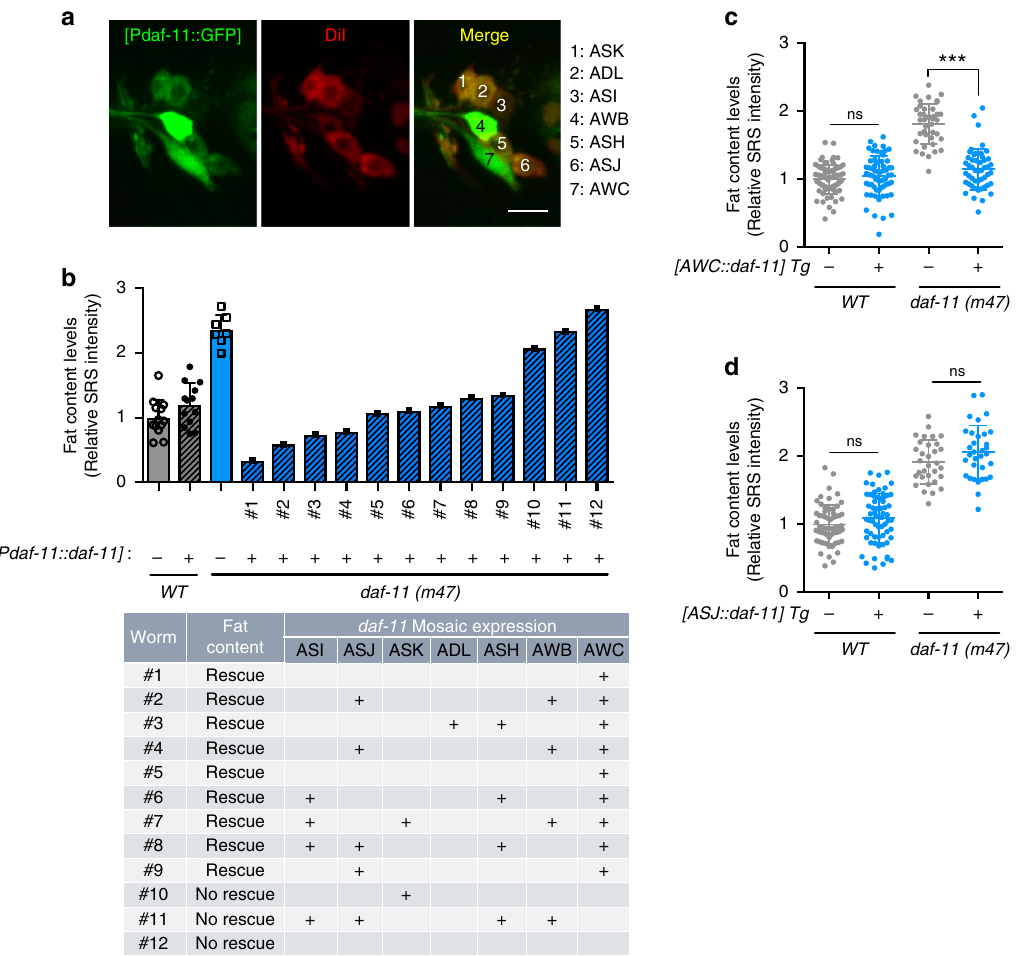
Fig. 2 Guanylate cyclase acts in olfactory neurons to regulate fat metabolism. a The [daf-11::GFP] integrated transgenic array shows the expression of daf-11 in seven pairs of head neurons: ASK, ADL, ASI, AWB, ASH, ASJ, and AWC. Scale bar = 10 μ m. b Mosaic analysis using the [daf-11::RFP] extrachromosomal transgenic array discovers that daf-11 expression in AWC olfactory neurons suf fi ciently rescues the increased fat storage in the daf-11 mutants. Individual worms that are mosaic for the transgenic array expression, are numbered 1 – 12 in the bar chart and in the table presenting the expression pattern. Error bars represent s.d. Individual worm images are in Supplementary Fig. 1b. c Using the ceh-36 promoter, speci fi c restoration of daf-11 only in AWC neurons is suf fi cient to suppress the increased fat storage in the daf-11 mutants. Representative SRS images are in Supplementary Fig. 6a. d Using the ssu-1 promoter, restoration of daf-11 expression speci fi cally in ASJ neurons does not suppress the fat storage increase in the daf-11 mutants. Representative SRS images are in Supplementary Fig. 6b. For c and d , data are mean ± s.d., *** P < 0.001, n.s. not signi fi cant by two-way ANOVA with Sidak ’ s multiple comparison test. For c – d , numbers of animals used are listed in Supplementary Data 1. For b – d , source data are provided as a Source Data fi